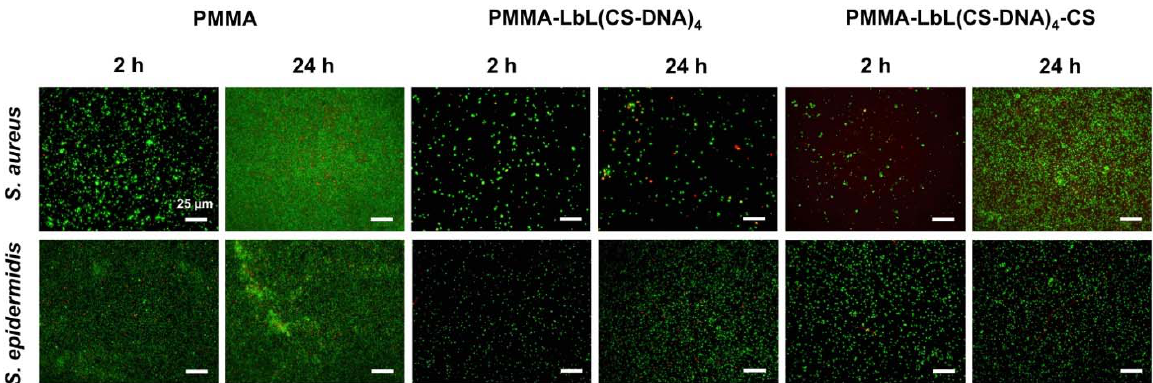
Figure 4. Representative fluorescence microscope images of adherent S. aureus ATCC 12598 and S. epidermidis ATCC 35984 on PMMA, PMMA-LbL(CS-DNA) 4 , and PMMA-LbL(CS-DNA) 4 -CS surfaces after incubation at 37 °C for 2 h and 24 h, respectively. Bacteria were stained using vitality staining solution (3.34 mM SYTO 9 and 20 mM propidium iodide in PBS) and were incubated for 15 min in the dark at room temperature. The scale bar denotes 25 µm.